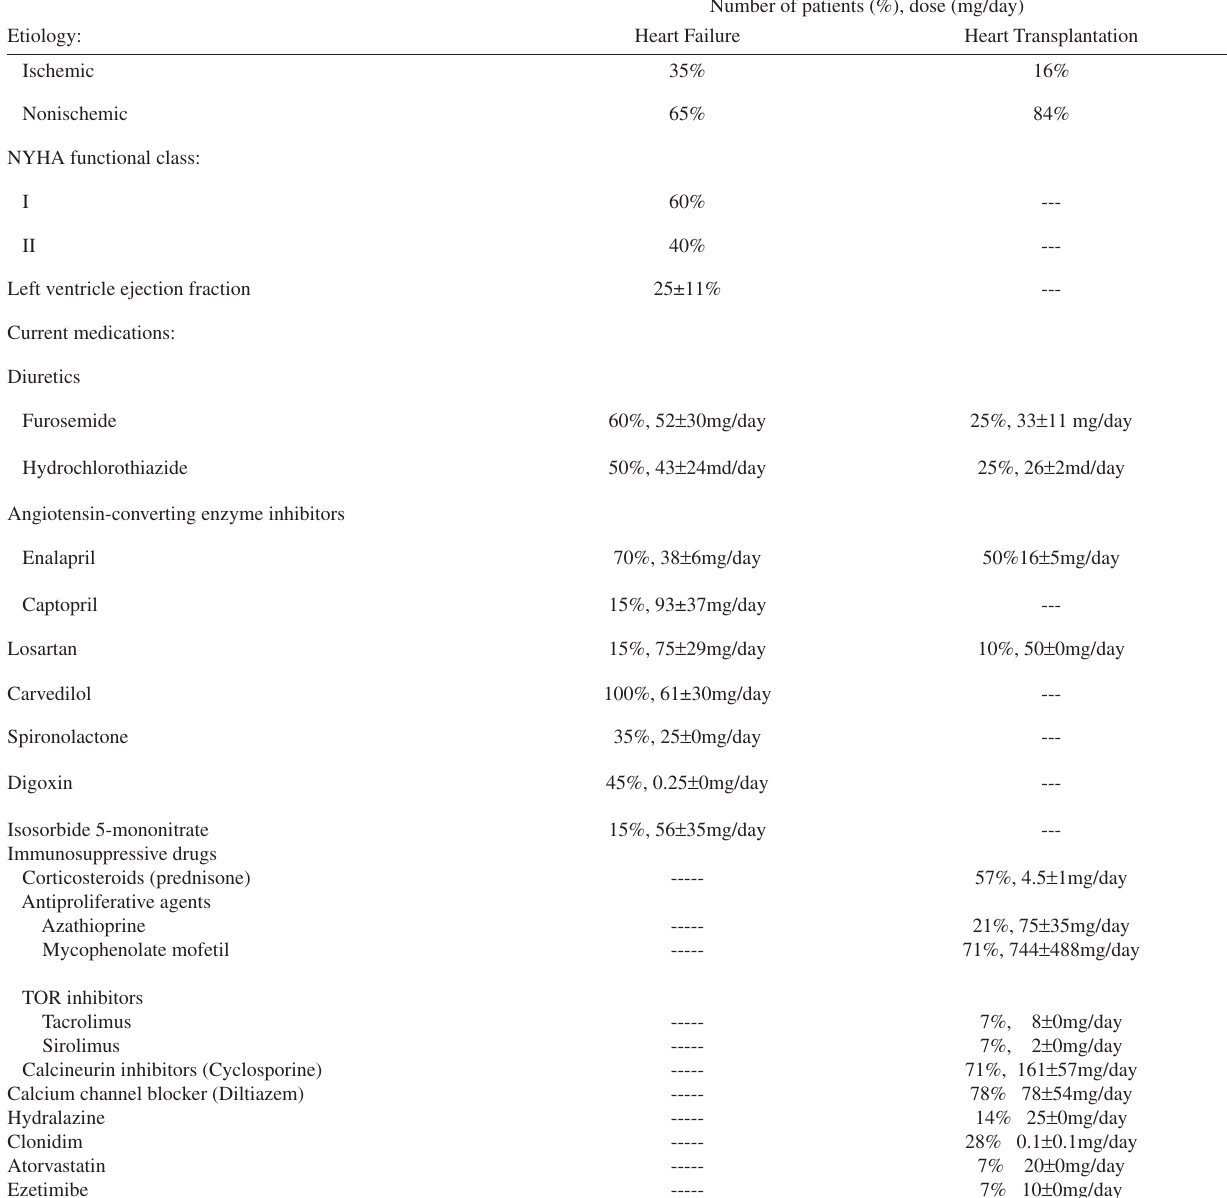
Table 1 - Patient